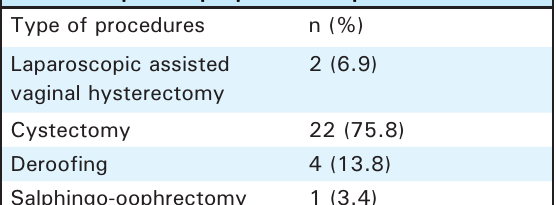
Table 3: Laparoscopic procedures performed